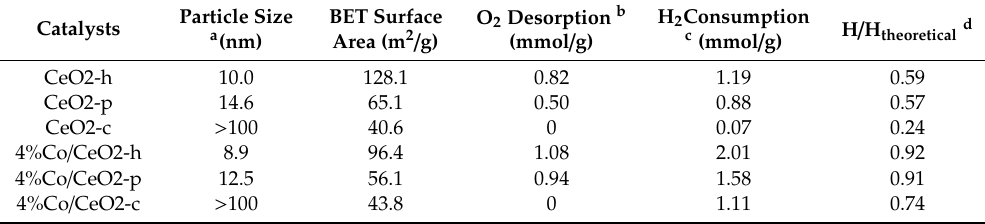
Table 1. Physical property of the CeO 2 supports and 4% Co / CeO 2